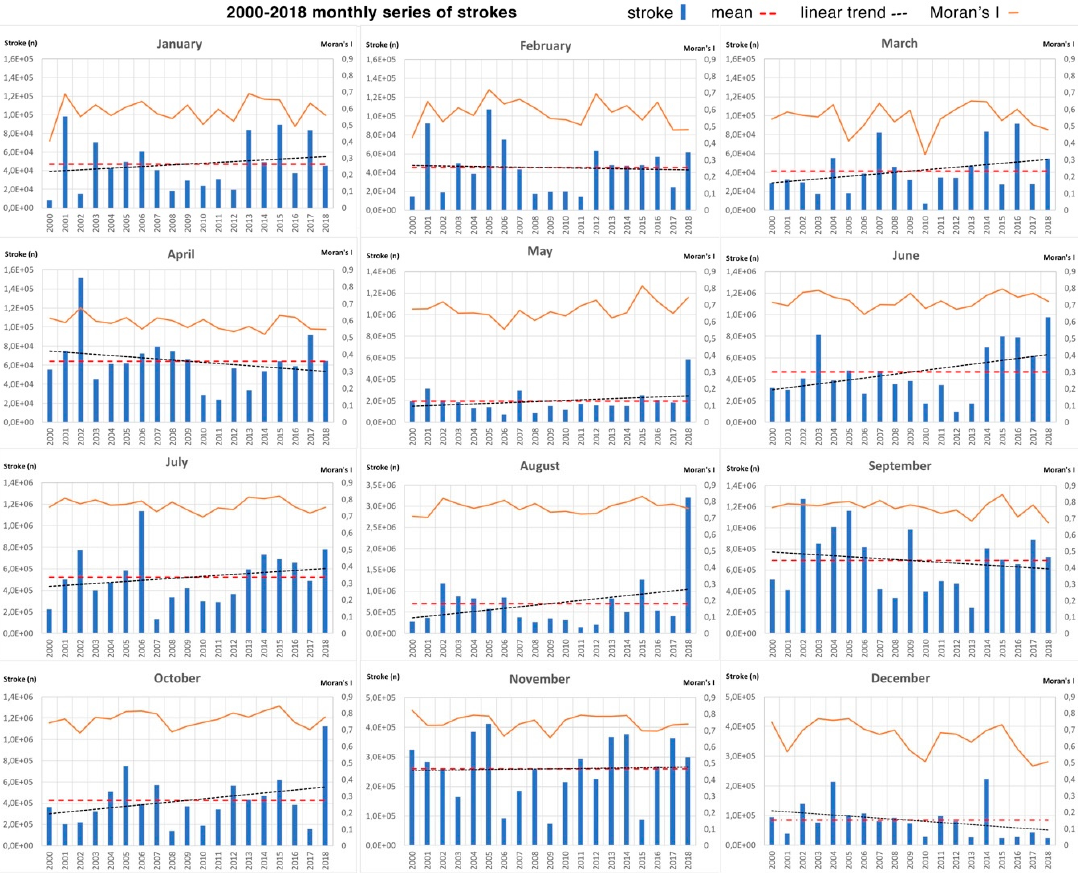
Figure 3. Monthly counts of cloud–ground strokes and global Moran’s I values, the mean for the total period, and the linear trend in the total measurement period.